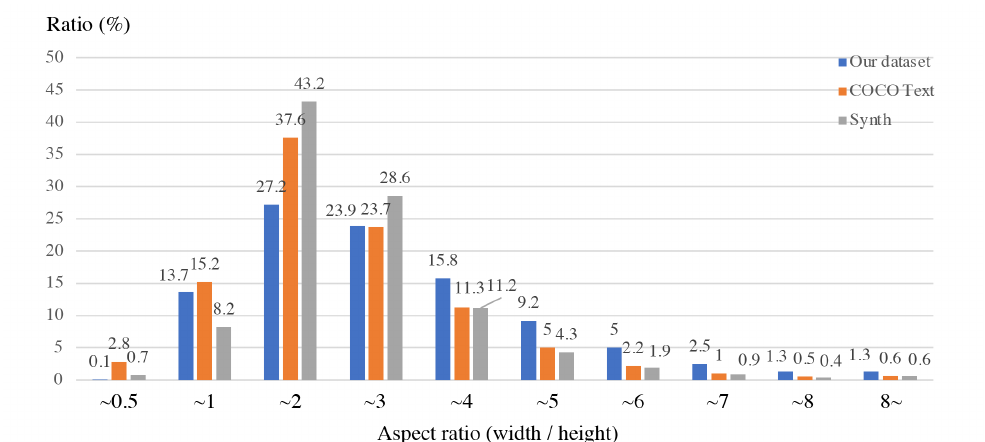
Figure 3. Histogram of the aspect ratio of texts in Datasets. Based on the above reasons, we proposed new anchors for text detection shown in Figure 4b. We eliminated vertically long anchors and added horizontally long anchors for the Latin text. Moreover, we added a small-scale anchor for tiny text. For large-scale text, Faster R-CNN prepares large scale anchors, and we do not add any large-scale anchors.